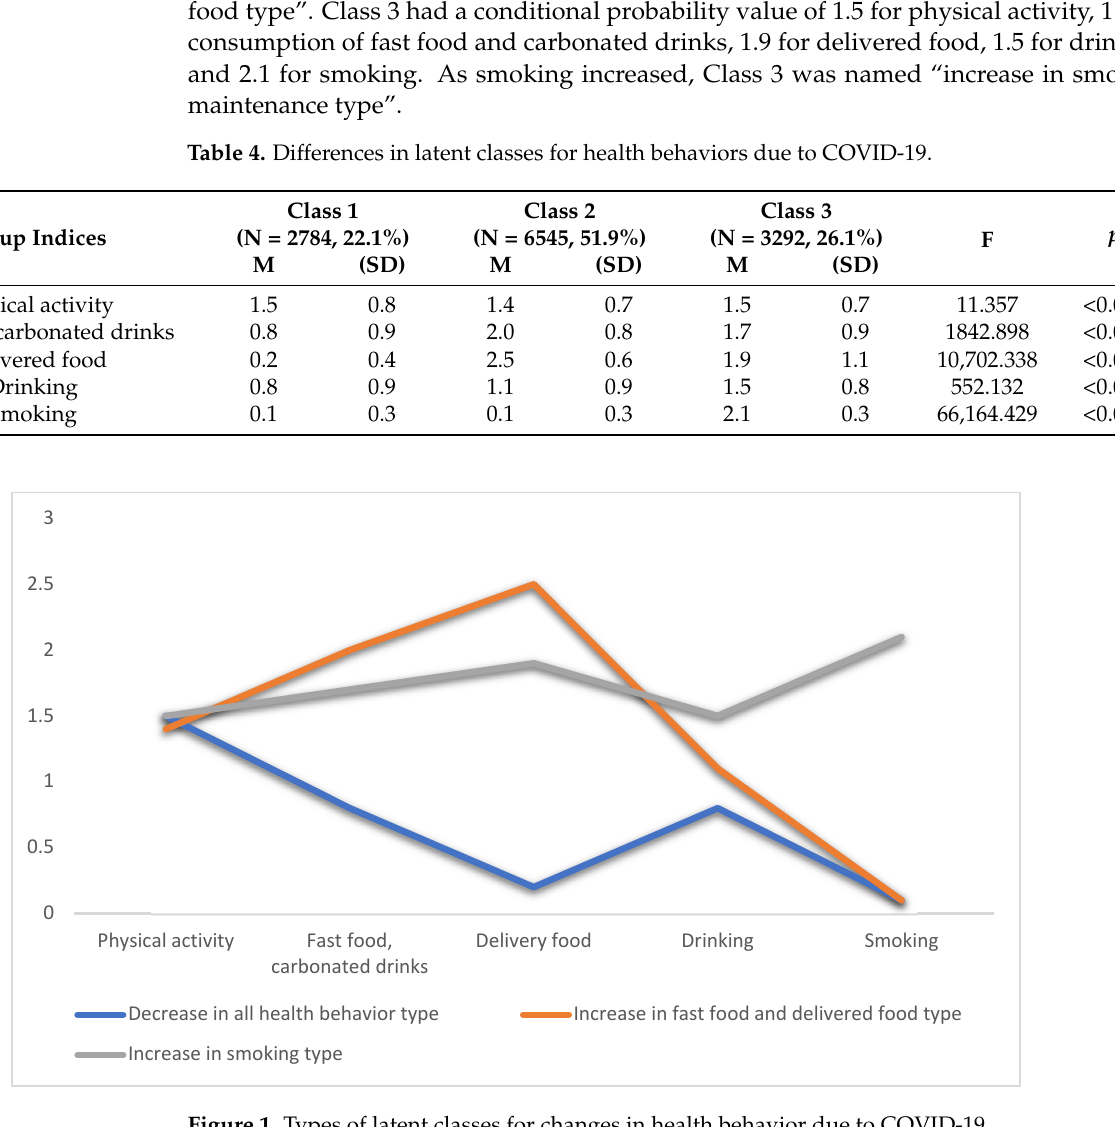
Figure 1. Types of latent classes for changes in health behavior due to COVID-19.